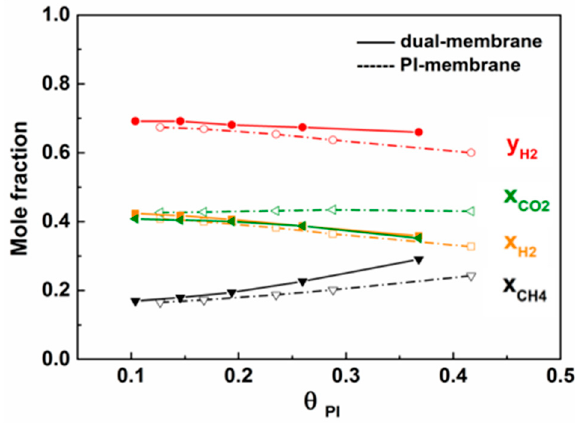
Figure 4. E ff ects of stage cut on performance of PI membrane separator and PI / PDMS dual Figure 4. Effects of stage cut on performance of PI membrane separator and PI/PDMS dual membrane membrane separator.